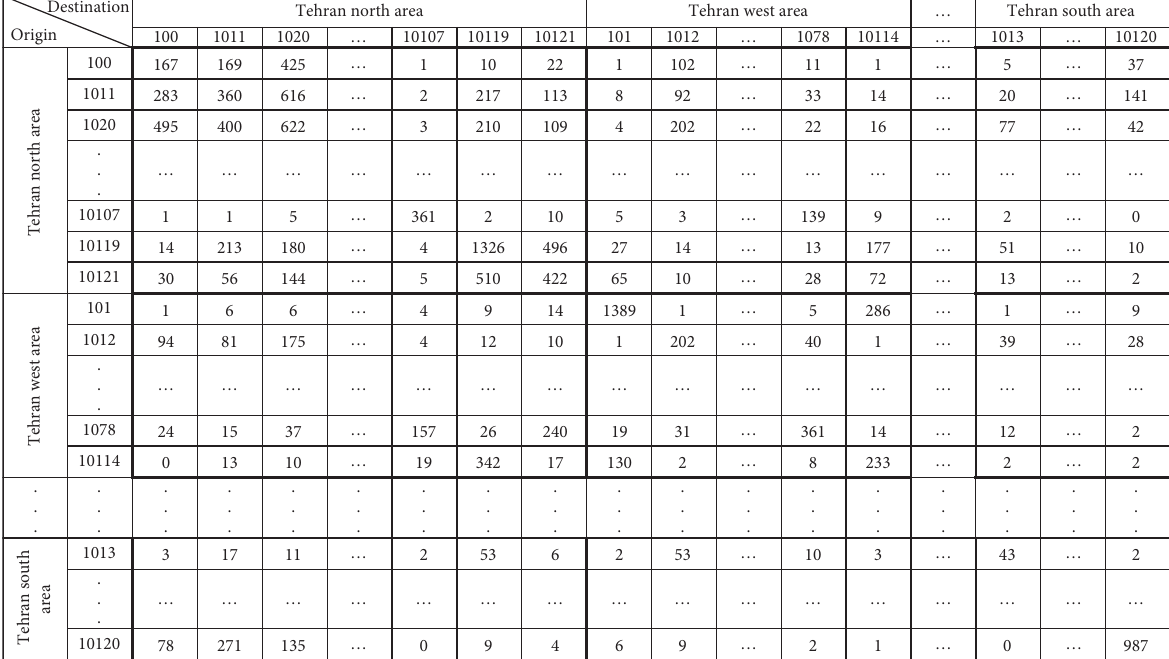
Figure 9: Local windows of GSSI in sample Table 2: The SLPSSI values for local windows from the origin (SLP Group1), Sunday versus Friday. Dest.